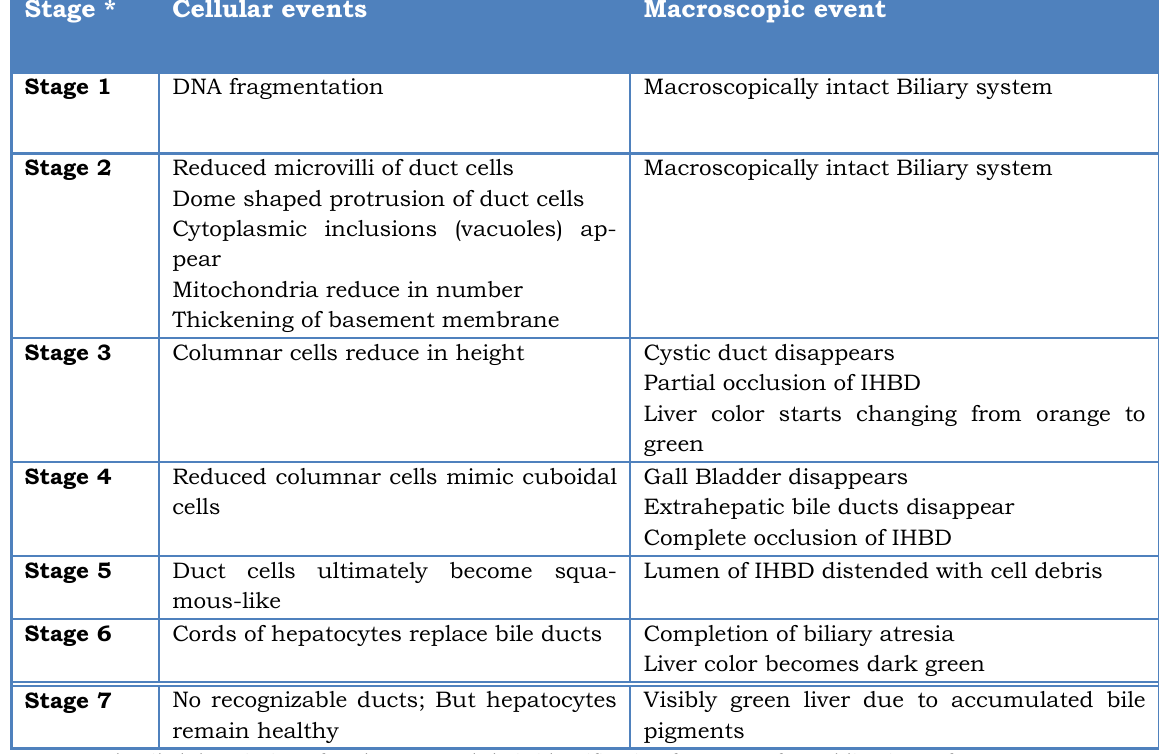
Table 1: Progression of biliary atresia through various stages of lamprey metamorphosis Stage *